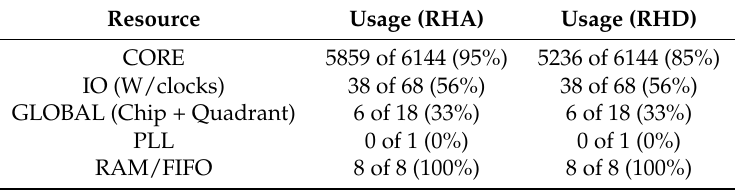
Table 1. Usage of the IGLOO nano FPGA (Field Programmable Gate Array) resources for an implant with Intan Technologies RHA or RHD analog front-end. A large portion (up to 33% in the case with Intan RHAs) of these core resources are by optional virtual RHAs/RHDs for testing purposes.